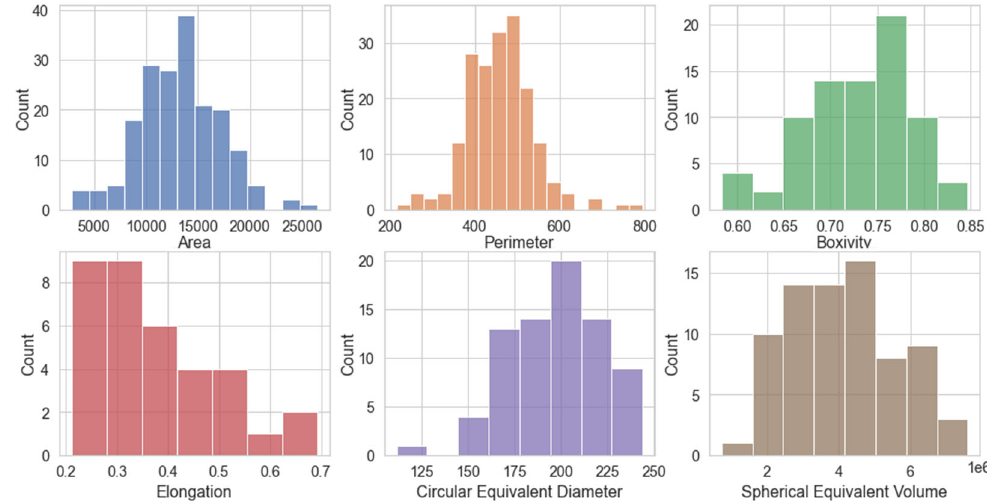
Figure 7. The calculated statistics based on a batch prediction from Mask-RCNN. Table 8. Color Mapping for the predicted batch visualization of the defined